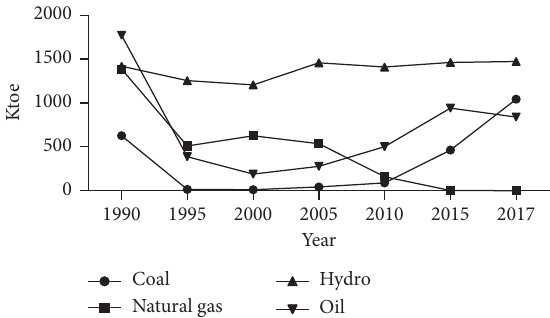
Figure 2: Total final consumption (TFC) by source, Tajikistan